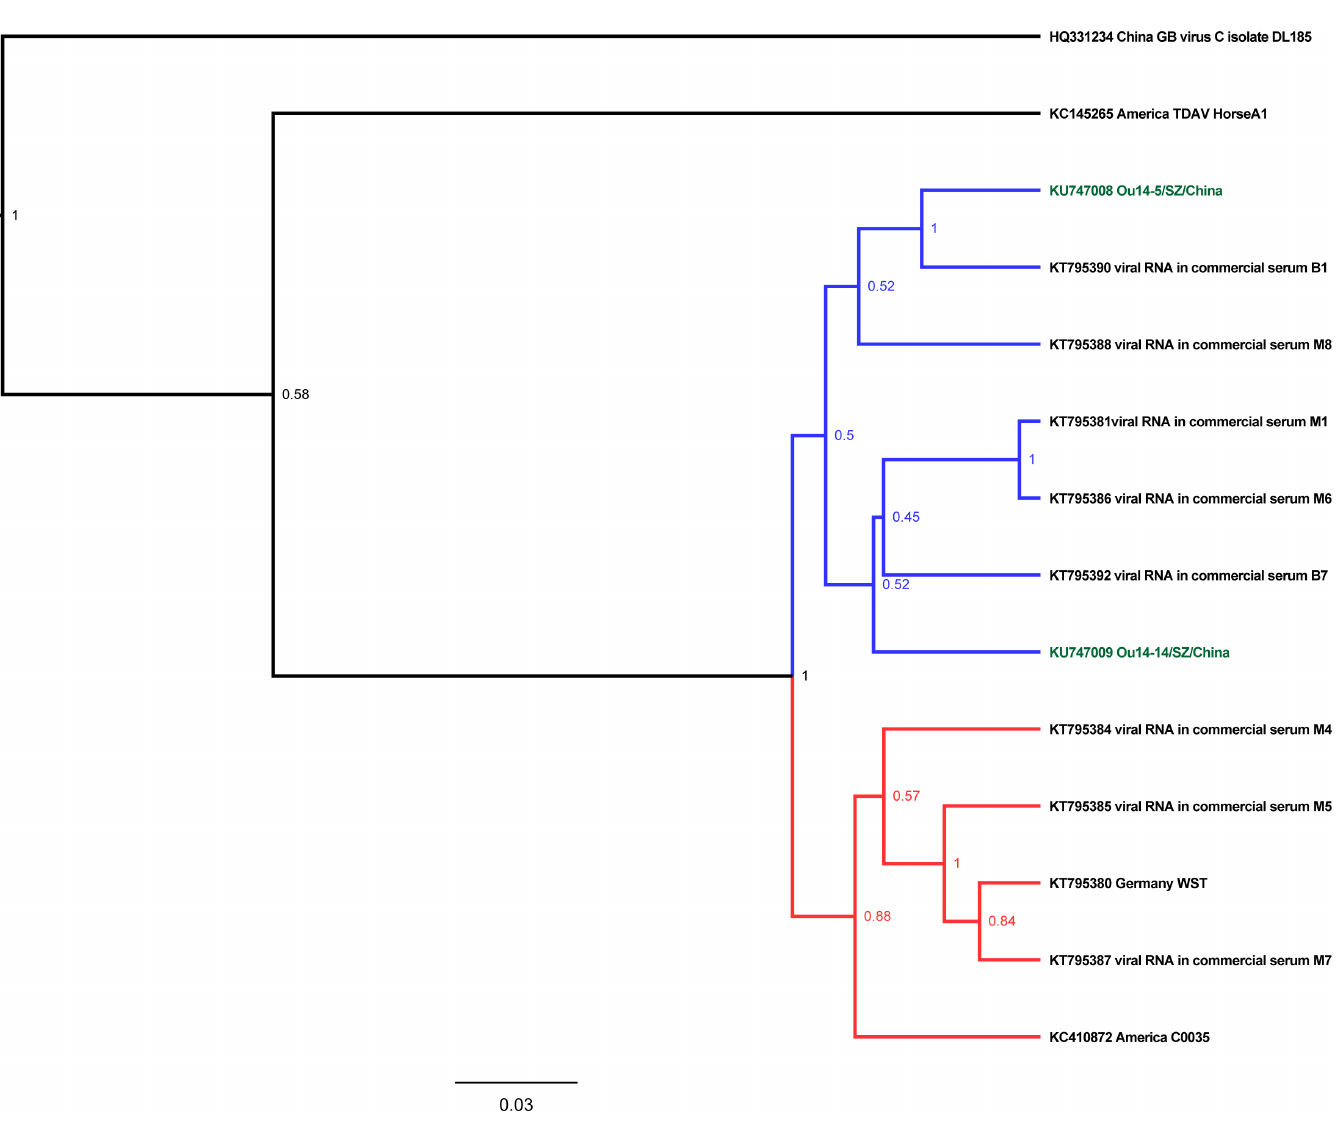
Fig 4. Phylogenetic analysis of the partial NS3 ORF sequences from EPgV. The analysis method has been described in Fig